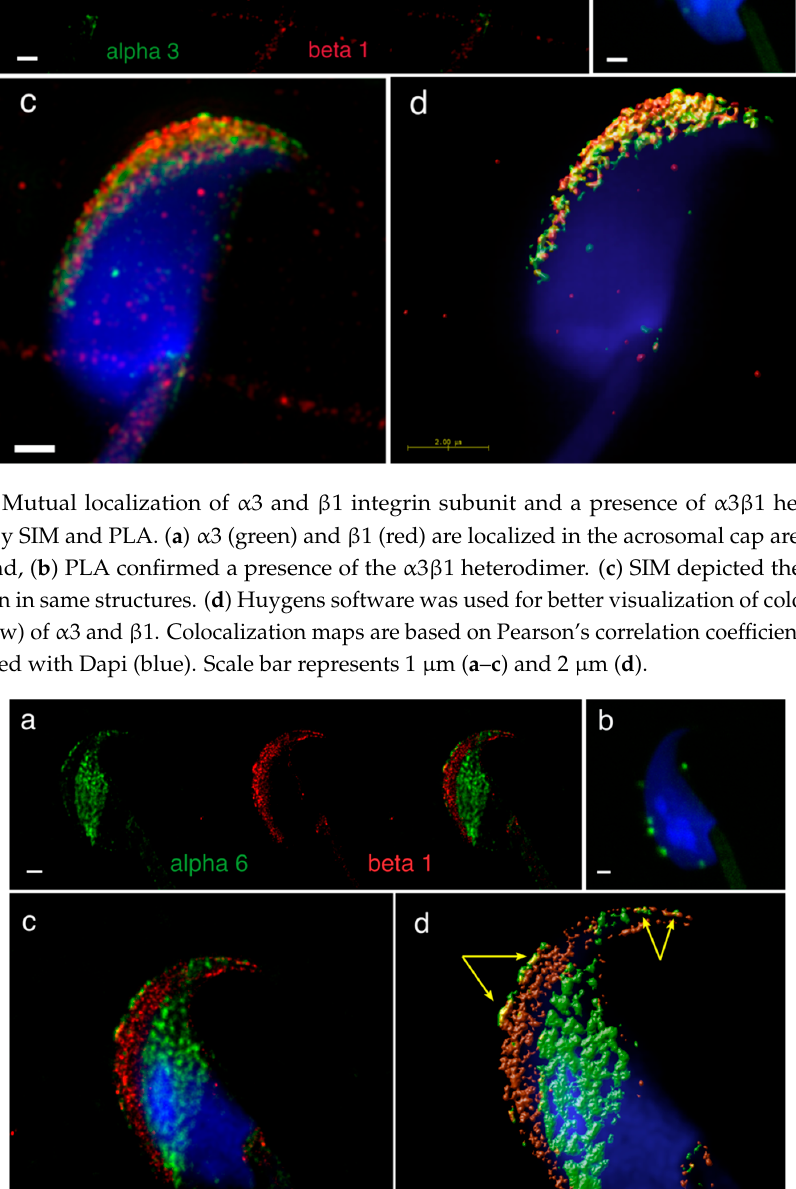
Figure 5. Mutual localization of α 6 and β 1 subunit and the presence of α 6 β 1 heterodimer reveals by STED (Stimulated Emission Depletion) super-resolution microscopy and PLA. ( a ) α 6 (green) is localized in plasma membrane over the acrosomal cap, apical hook and equatorial segment in contrast to β 1 (red) localized in plasma membrane overlying the acrosomal cap stretching to apical hook and in outer acrosomal membrane. ( b ) PLA confirmed the presence of the α 6 β 1 heterodimer in mutual places such as the plasma membrane over the acrosomal cap and apical hook. ( c ) STED dual-color imaging present overlay of both subunits. ( d ) Huygens software was used for better visualization of colocalization area (yellow, pointed by yellow arrows). Colocalization maps were based on Pearson’s correlation coefficient. Nucleus is visualized with Dapi (blue). Scale bar represents 1 μ m ( a , b , c , d ).